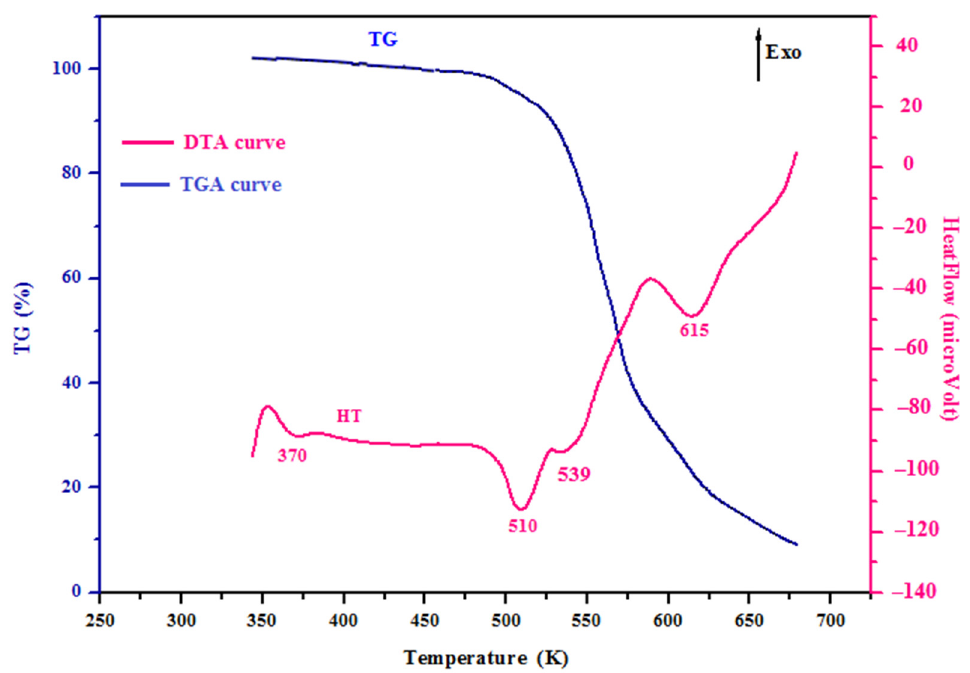
Figure 11. TGA-DTA curves for (C 5 H 14 N 2 )[HgCl 4 ]·H 2 O.